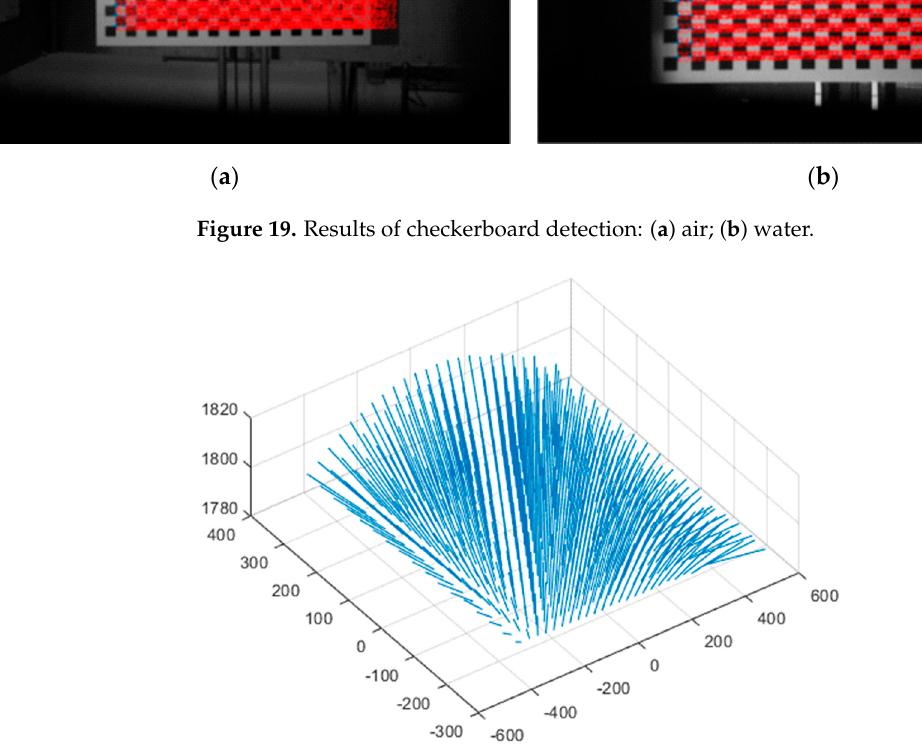
Figure 20. Estimation of measurement error due to refraction.